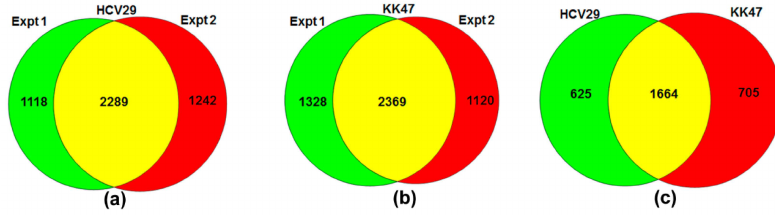
Figure 1. Distributions of proteins identified in experiments described in the text. Venn diagrams of numbers of identified proteins in EMT of HCV29 ( a ) and of KK47 ( b ) from individual experiments, and in EMT of both HCV29 and KK47 ( c ).